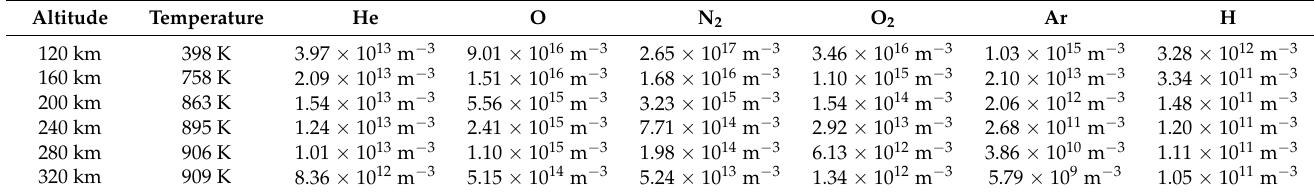
Table 6. Background atmospheric temperature and numerical density of various molecules at different altitudes under medium F10.7 and low Ap environments (ML).